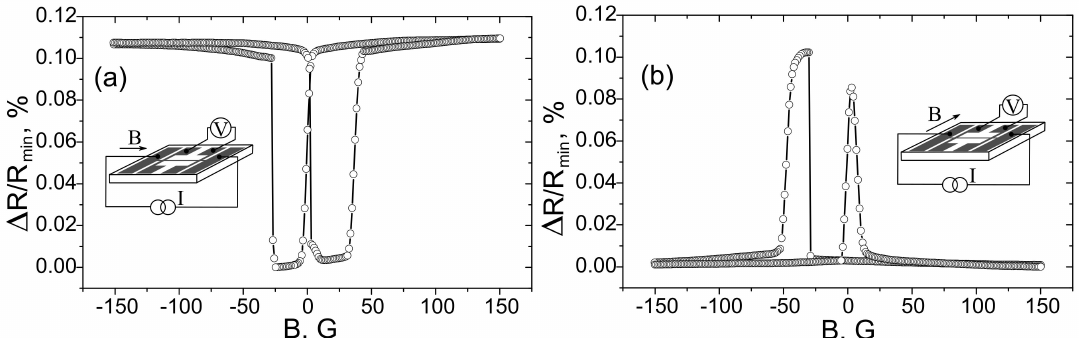
Figure 1. The dependence of the FeMn/Fe/Mo/R-sapphire bridge-resistance against an applied in-plane external magnetic field. It is perpendicular to the bridge in ( a ), and parallel to the bridge in ( b ). The magnetic field during the sample annealing procedure was always applied perpendicular to the bridge in the plane of the